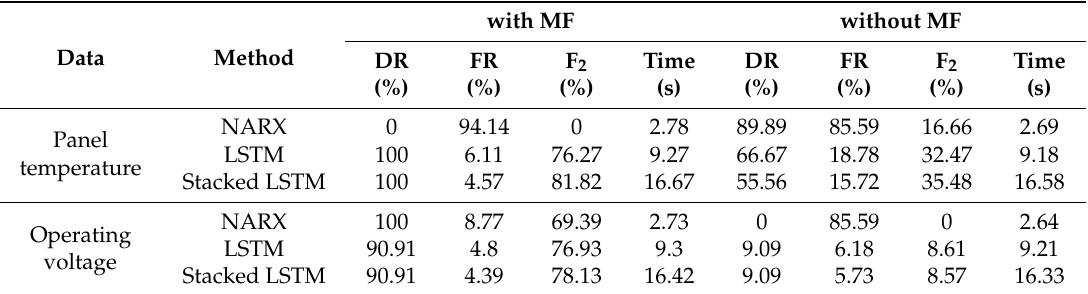
with the external input (NARX) for the panel temperature and operating